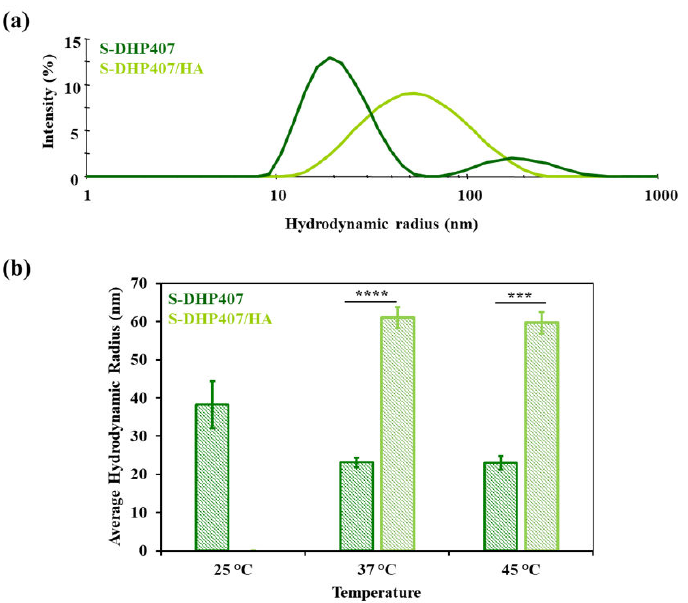
Figure 7. ( a ) Representative hydrodynamic radius vs. intensity profiles acquired for S-DHP407 (dark green) and S-DHP407/HA 50/50 w / w (light green) at 37 ◦ C. ( b ) Average hydrodynamic radius calculated for S-DHP407 (dark green) and S-DHP407/HA 50/50 w / w (light green) formulations at 25 ◦ C, 37 ◦ C and 45 ◦ C. (*** p = 0.0004 and **** p <